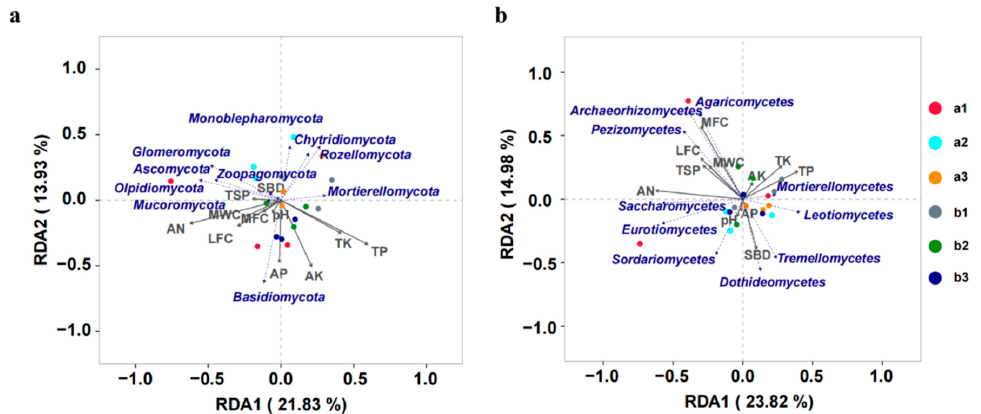
Figure 5. Redundancy analysis (RDA) ordination plots demonstrate the relationship between soil physical and chemical properties and fungal communities at the ( a ) phylum and ( b ) class levels. The arrows indicate the length and angle between the explanatory and response variables and reflect their correlations. Different samples are marked in different colors. a1, a2, and a3 represent the bulk soil samples of the uphill plots, and b1, b2, and b3 represent the bulk soil samples of the downhill plots.